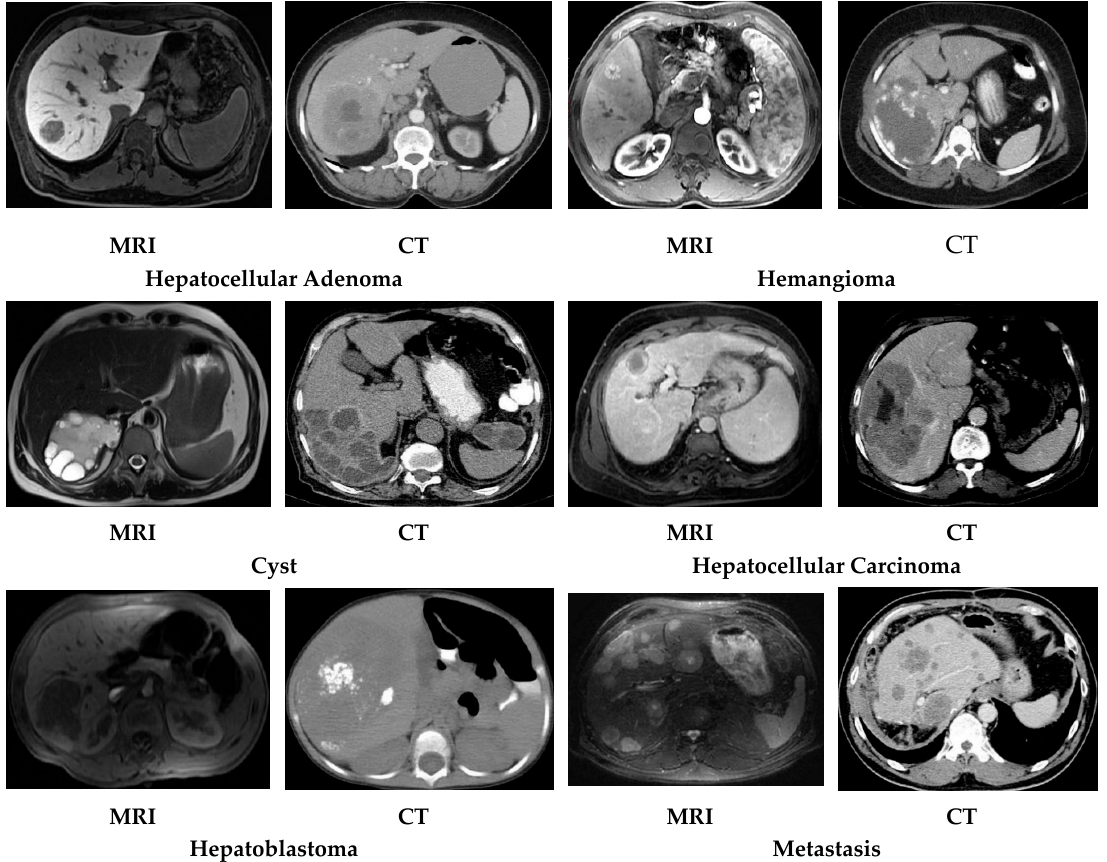
Figure 1. Typical six liver cancer CT and MR image datasets.